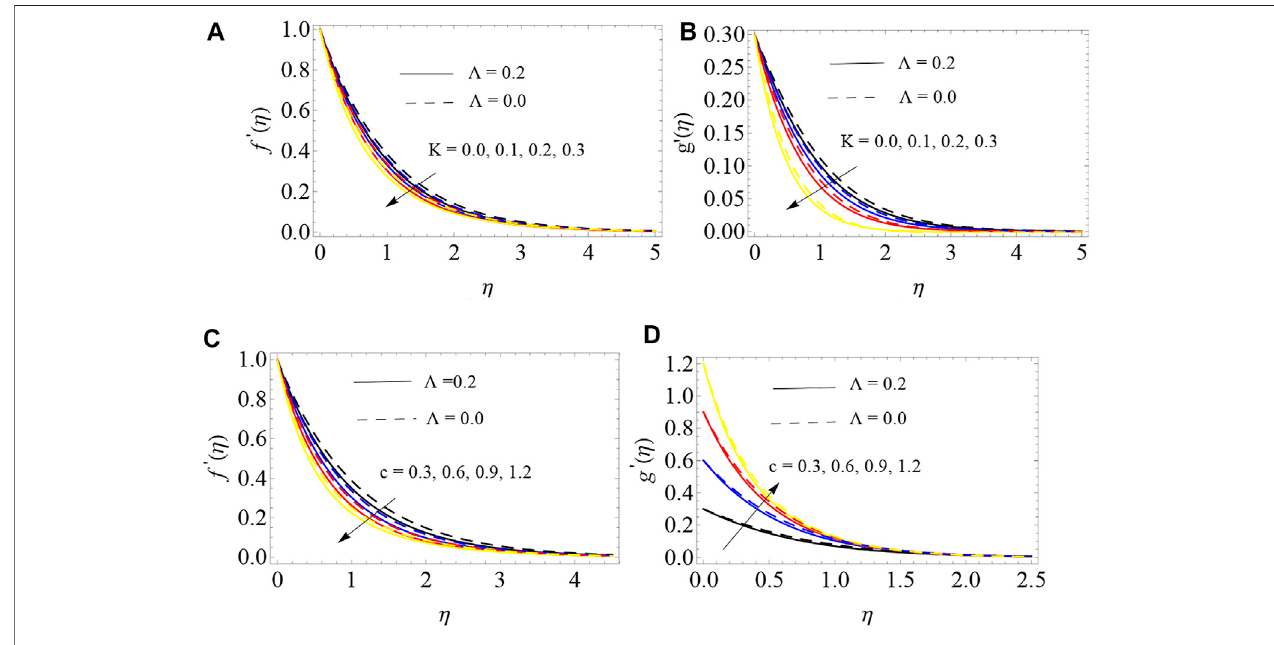
FIGURE 3 | The impact of “ K ” and “ c ” on both velocity pro fi